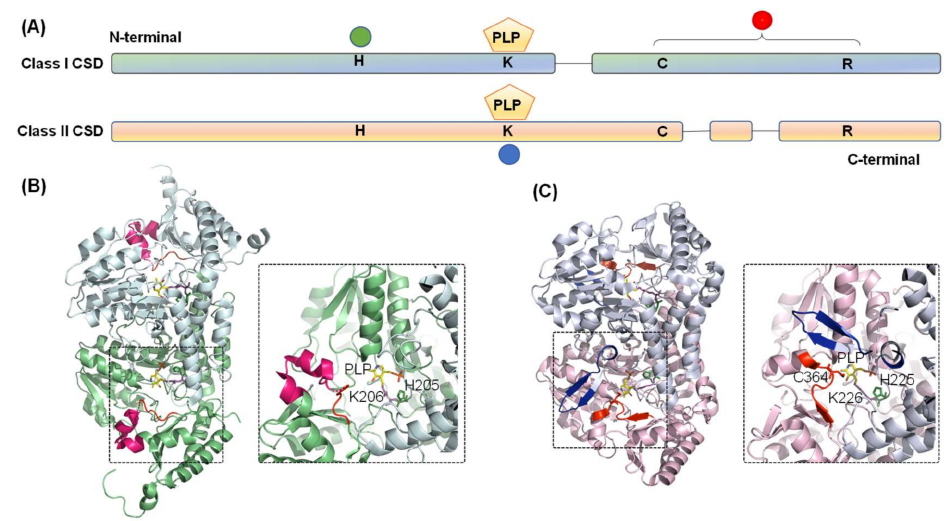
Figure 3. Diagram representing the domain architecture of CSD from Classes I and II. ( A ) The green circle indicates conserved histidine residue involved in acid-base catalysis and interaction with PLP-L-cysteine. Conserved cysteine and arginine residues are in the catalytic loop region, as indicated by the red circle. PLP is pyridoxal-5 (cid:48) -phosphate is covalently bound to conserved lysine residue (blue circle). Comparison of the three-dimensional structures of the ( B ) Class I ( E. coli IscS, PDB ID- 3LVM) and ( C ) Class II ( E. coli SufS, PDB ID- 6UY5) CSD enzymes highlights the differences between the two classes. Conserved histidine, lysine, and catalytic cysteine residues are shown as stick representation in forest green, magenta, and red. The PLP moiety is shown in yellow. Identifiers I–III are highlighted in red, blue, and hot pink,